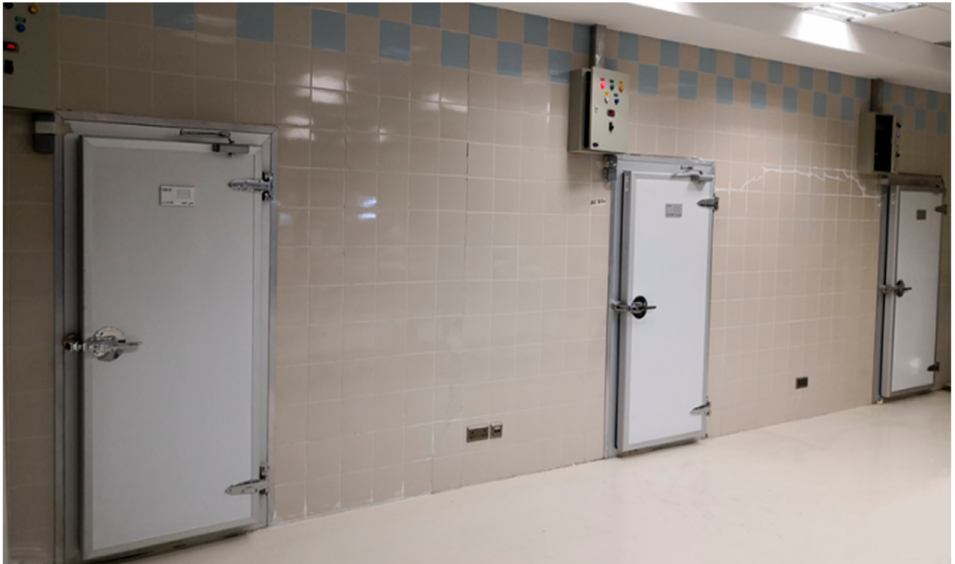
Figure 4. The three experimental cold storage